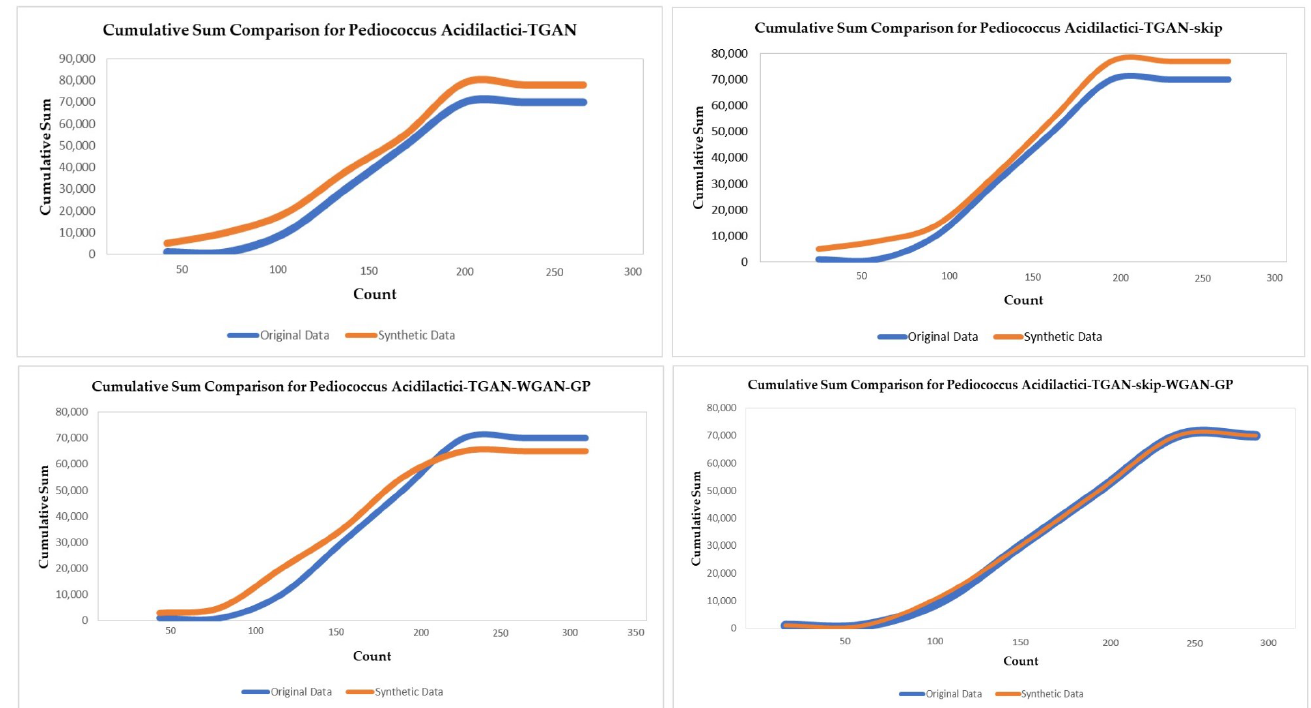
Figure 11. Cumulative sum of coloum ‘count’ for the Pediococcus acidilactici microbial